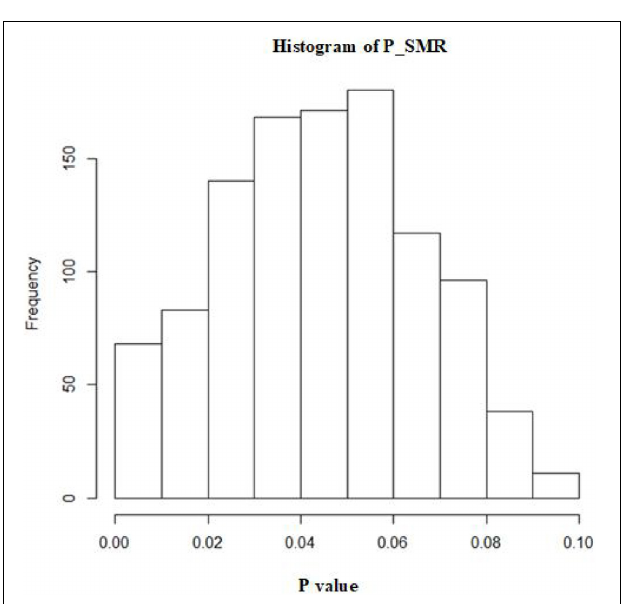
FIGURE 4 | The distribution of SMR p -values of